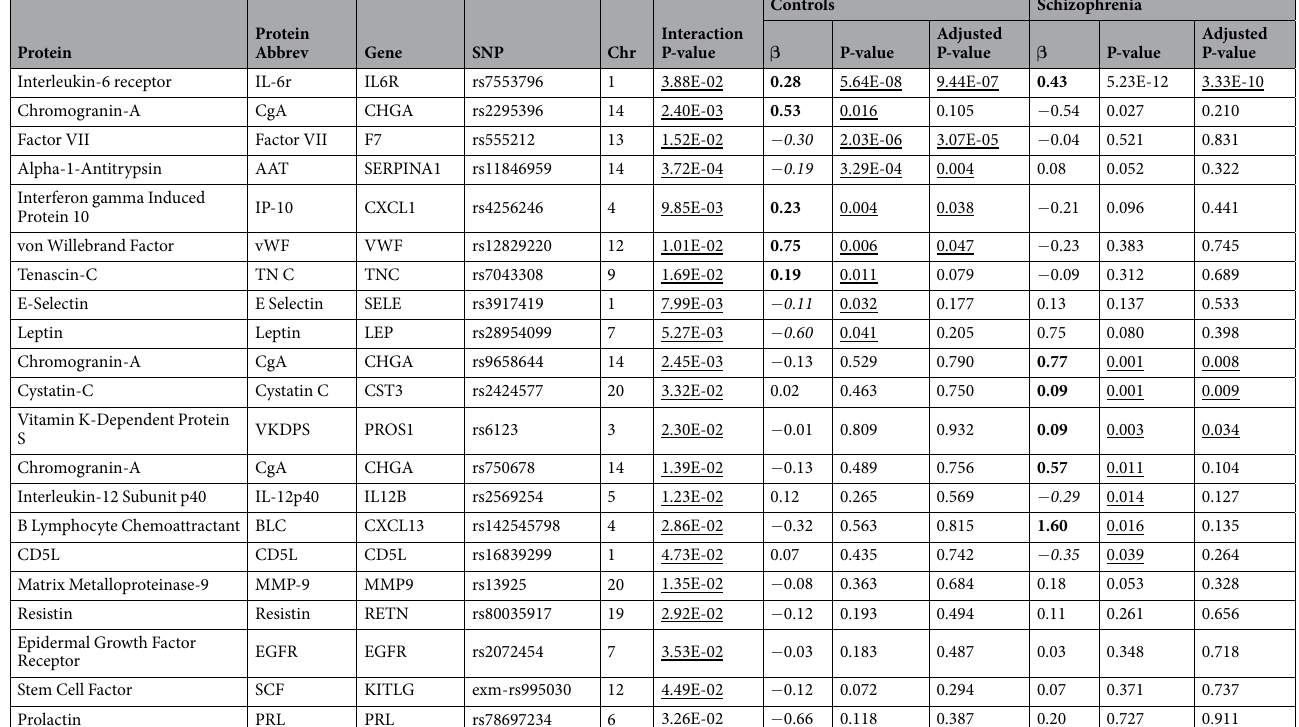
Table 3. Significant SNP x Diagnosis interaction and results stratified by diagnosis. Table showing the significant SNP and protein expression associations stratified by diagnosis for the regression models where SNP x Diagnosis interaction was significant. A significant SNP x Diagnosis interaction indicates that effect of SNPs on protein expression varies with diagnosis (binary case/control status). Key : Interaction P-value, SNP x Diagnosis interaction